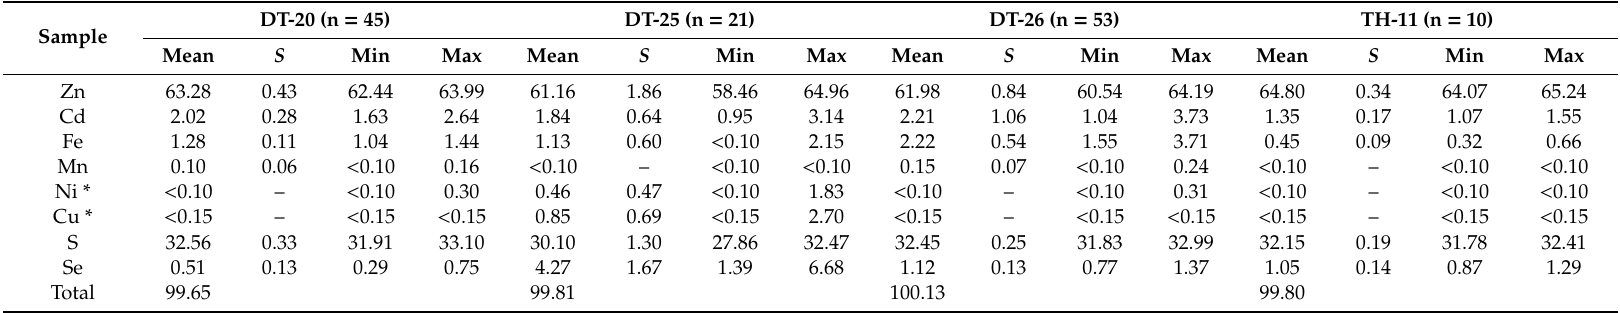
Table 10. Average compositions of sphalerite from CM marbles, Tulul al Hammam area (SEM-EDS and EPMA, wt%). Sample